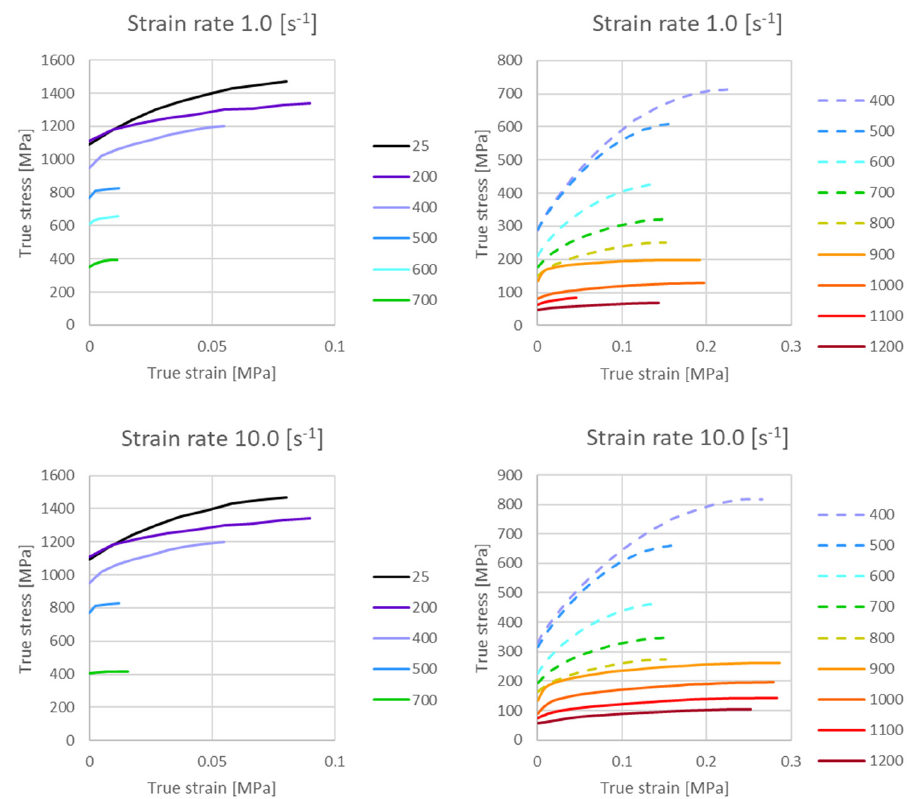
Figure 5. Plastic flow curves for strain rates of 0.01 s − 1 , 0.1 s − 1 , 1.0 s − 1 , 10 s − 1 for the base material (left) and for austenite (right), dashed lines show extrapolations (right).